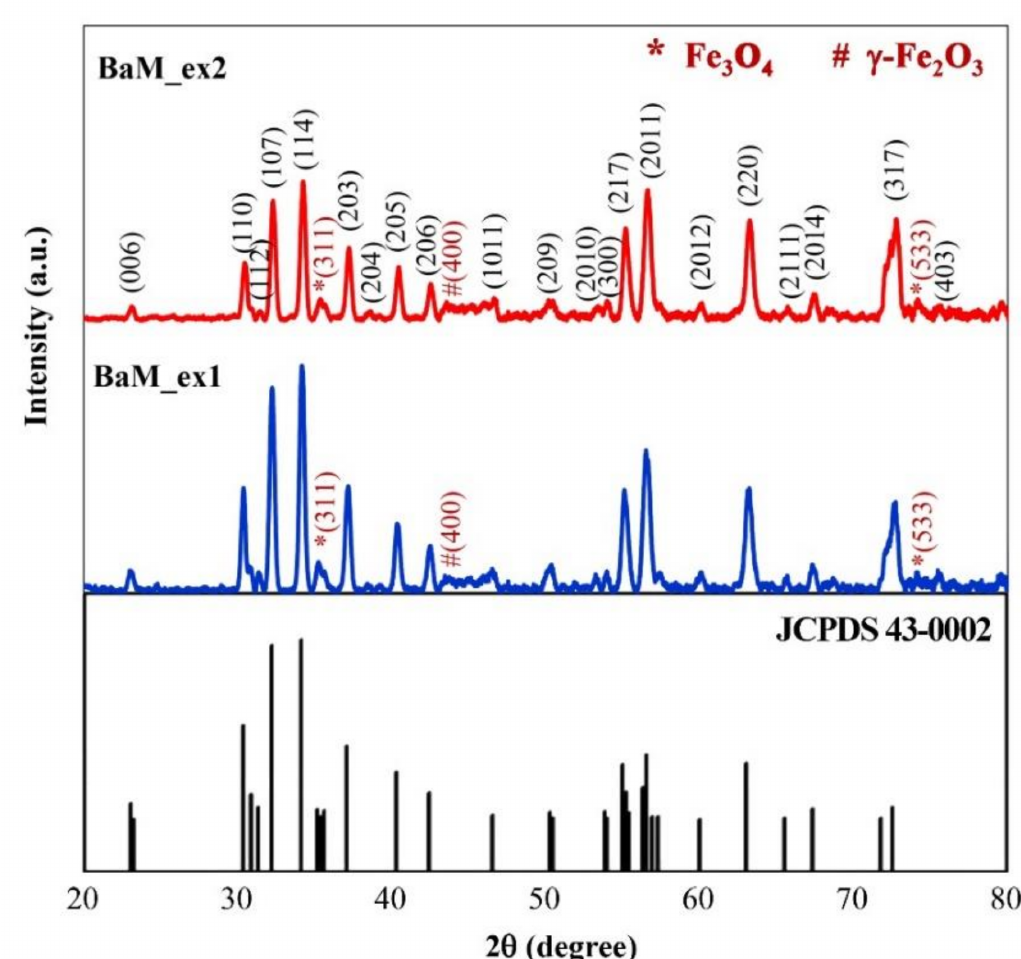
Figure 3. XRD patterns of sol-gel derived products after calcination.